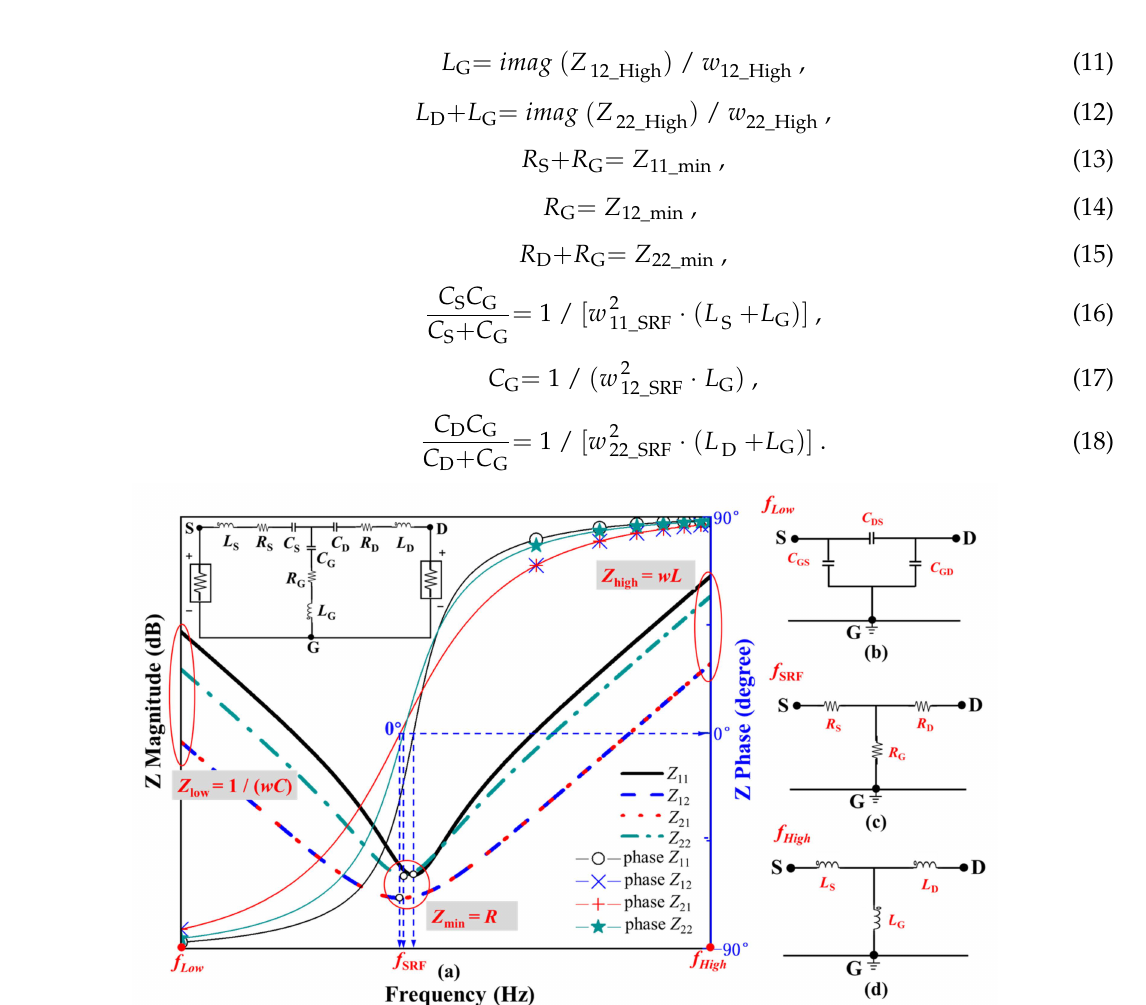
Figure 6. MOSFET parasitic parameter extraction theory. ( a ) Impedance magnitude and phase curves of a typical MOSFET. ( b ) Two-port network representation for the MOSFET at low frequency. ( c ) Two- port network representation for the MOSFET at the f SRF . ( d ) Two-port network representation for the MOSFET at high